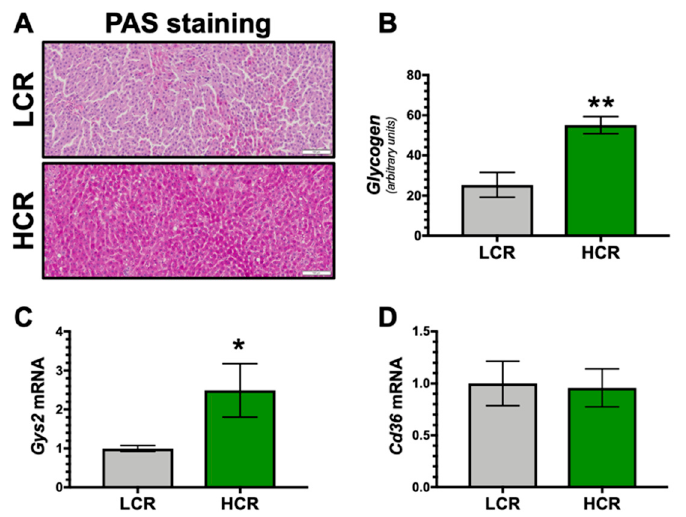
Figure 5. Hepatic glycogen and C36 levels in LCR and HCR rats. ( A ) Representative hepatic Periodic acid–Schiff (PAS) staining. ( B ) Quantification of hepatic glycogen staining. ( C ) Hepatic glycogen synthase-2 ( Gys2 ) mRNA levels. ( D ) Hepatic CD36 ( Cd36 ) mRNA levels. * p < 0.05 as compared to LCR rats. ** p < 0.001 as compared to LCR rats. Scale bar = 100 µm. n = 9/group.